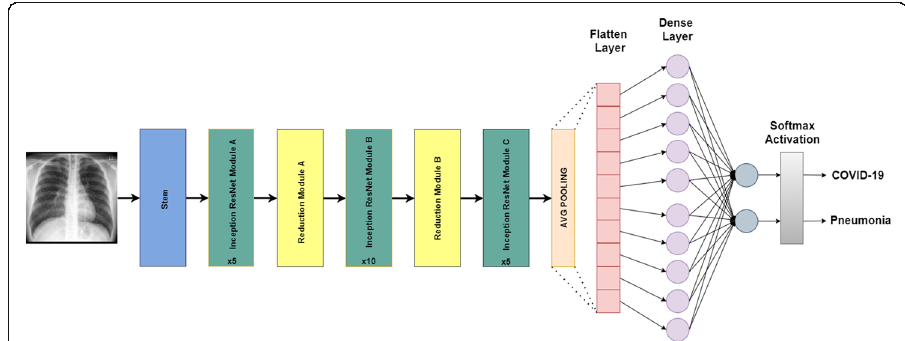
Fig. 4 Inception-ResNet-V2 architecture designed for binary classification